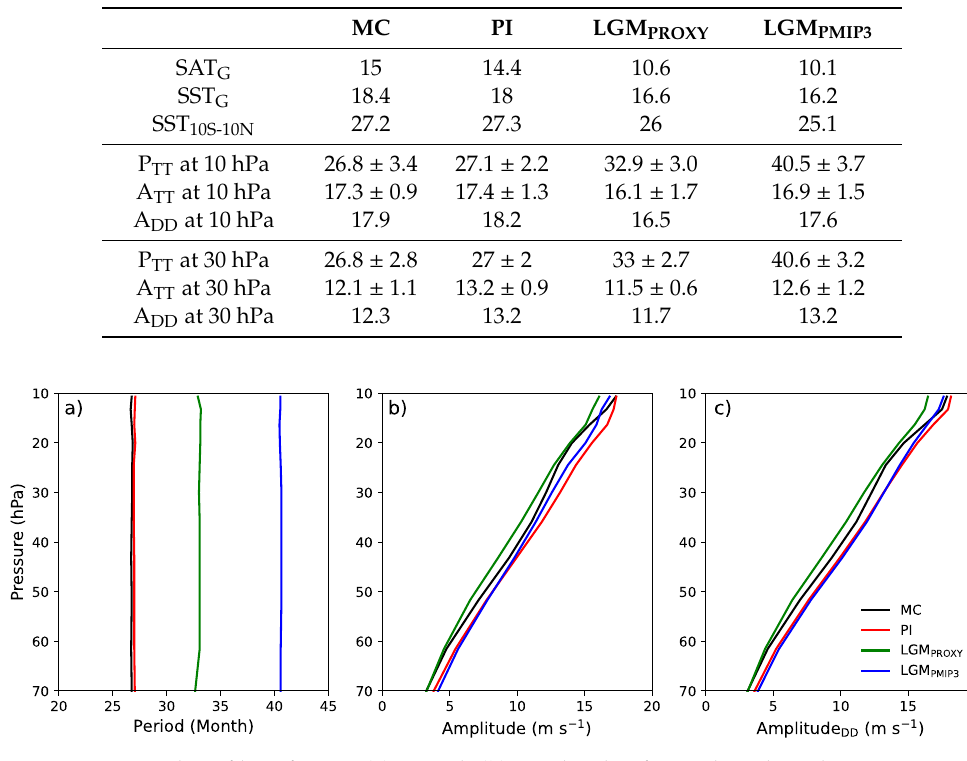
Figure 2. Vertical profiles of mean ( a ) period, ( b ) amplitude of QBO based on the transition time method, and ( c ) QBO amplitude following Dunkerton and Delisi (1985), for the simulations of Last Glacial Maximum with the PMIP3-simulated SST (LGM PMIP3 ), Last Glacial Maximum with the proxy SST (LGM PROXY ), and modern (MC) and preindustrial (PI) climate with observed SST and sea ice. The global‐mean surface air temperatures are 15.0, 10.6, and 10.1 °C for the MC, LGM PROXY , and LGM PMIP3 , respectively, corresponding to global‐mean SSTs of 18.4, 16.6, and 16.2 °C (Table 1). The global‐mean surface air temperatures and SSTs from LGM PMIP3 are thus only ~0.4–0.5 °C lower than LGM PROXY . However, the SSTs averaged over 10° S–10° N, which are more relevant to QBO, are 27.7, 26.0, and 25.1 °C for MC, LGM PROXY , and LGM PMIP3 , respectively (Table 1). The SST over the deep tropics for LGM PMIP3 is thus 0.91 °C lower than LGM PROXY . Figure 3 shows the mean QBO periods versus SST averaged over 10° S–10° N, indicating an increase in the QBO period with a decrease in SSTs over the deep tropics.